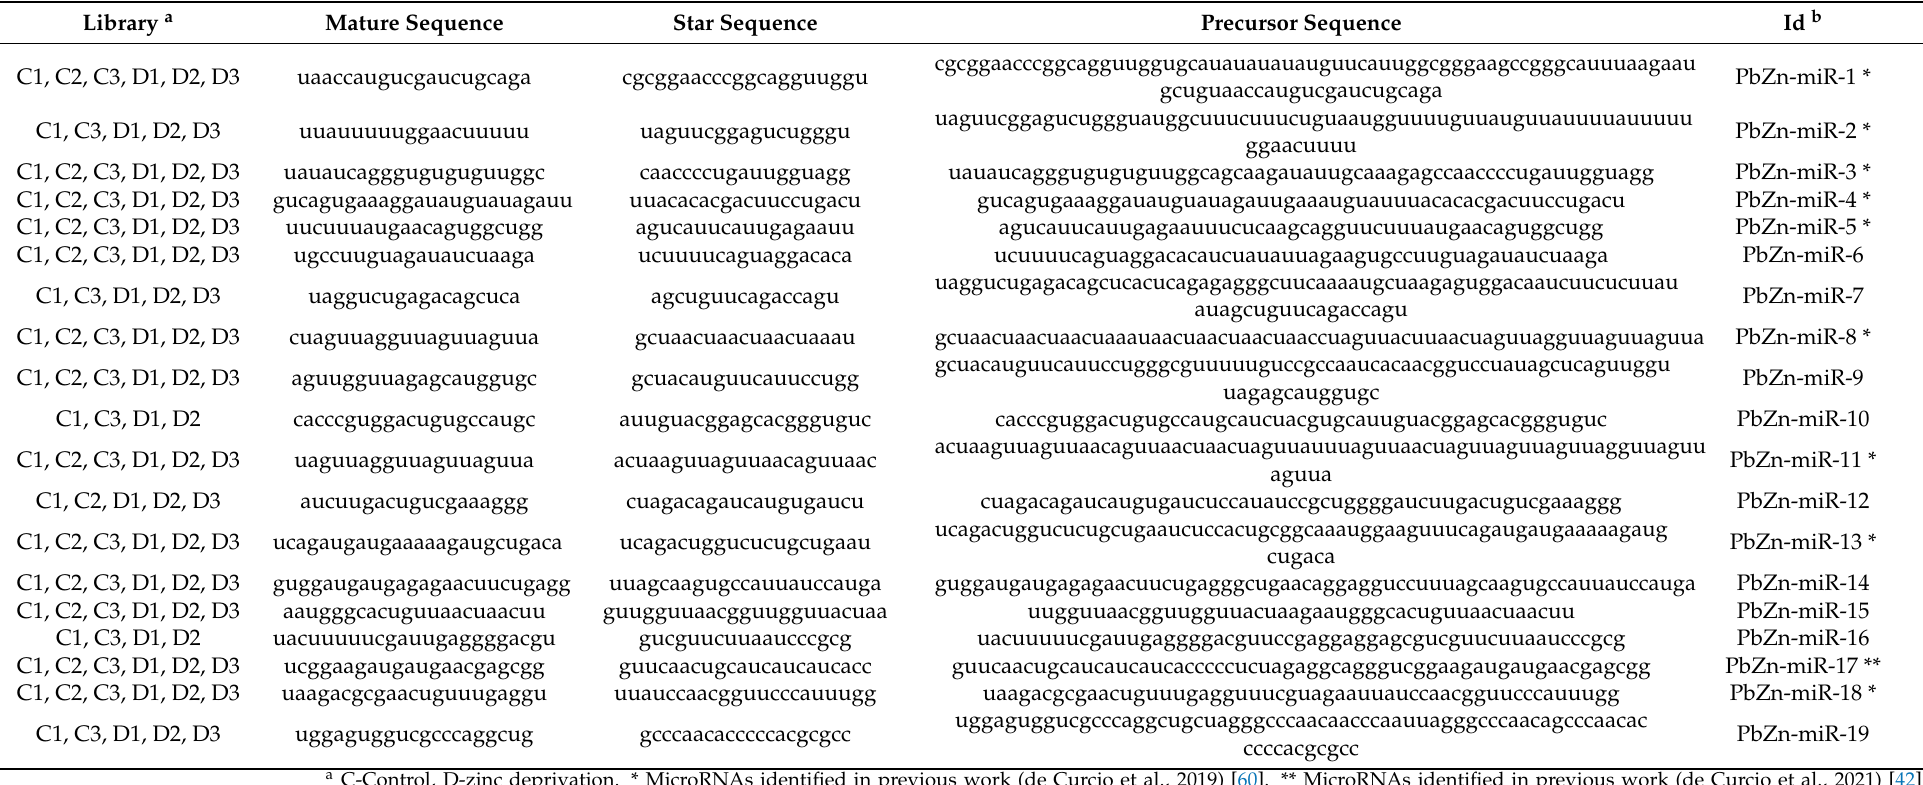
Table 1. MiRNAs present in P. brasiliensis yeast cells, cultured in the presence or deprivation of zinc. Library a Mature Sequence Star